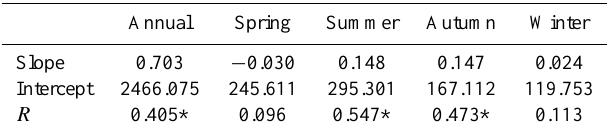
Table 3. Linear regression coefficients of annual and seasonal dif- fuse radiation from 1981 to